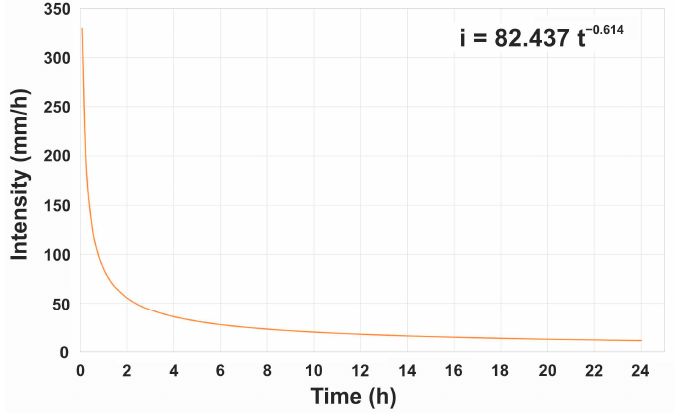
Figure 7. The IDF function and curve (point rainfall intensity vs. time) for the Anavra station for a return period of 1000 years.